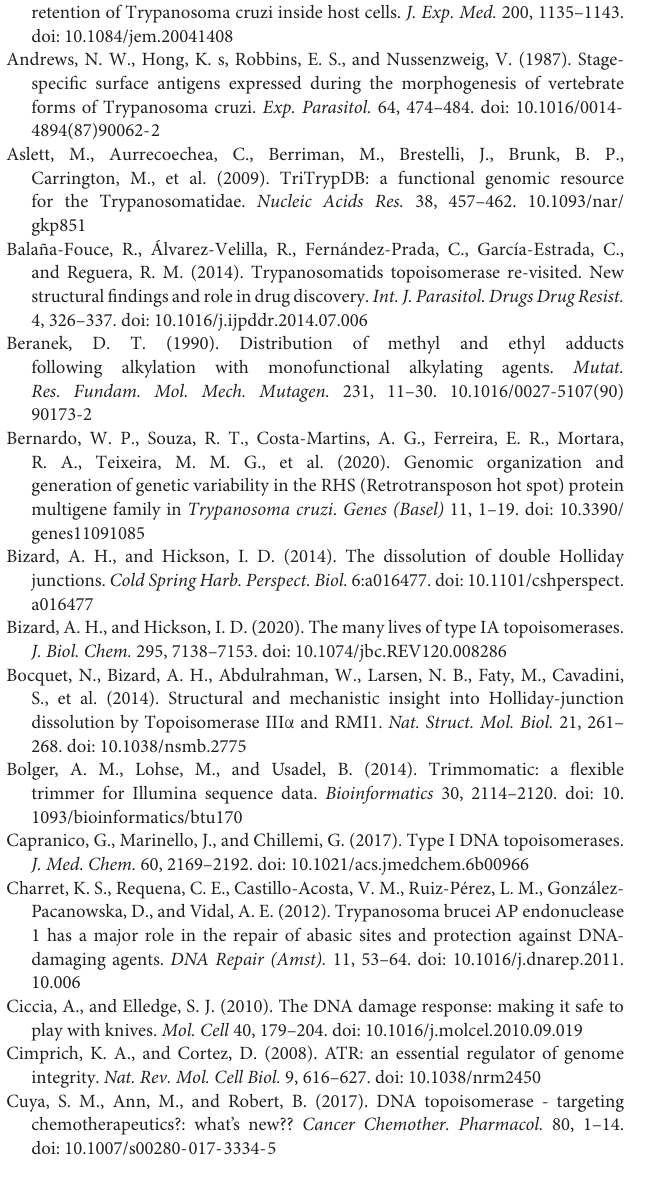
For each multigene family, two heatmaps were generated, one containing the read depth normalized by genome coverage (Raw-Counts), and one with the values normalized by Z-score by column. There was a significant reduction in counts on DGF-1 and RHS gene families, and a mild reduction in Trans-sialidases in MM1 and MM2, when compared with NT1 and NT2. Supplementary Figure 9 | Violin plot representing the gene copy number of DGF-1 genes near replication origins. (A) The Y axis represent the distribution of gene coverages, in log scale. MMS-treated DGF-1 non-origin (MMSNO – red), MMS-treated DGF-1 origin (MMSO – green), Non-Treated non-origin (NTNO – blue), and Non-Treated origin (NTO – purple). (B) Z-statistic and p -values of Dunn’s test. P -values < 0.05 are highlighted in red, and p -values ∼ 0.05 are highlighted in orange. There was no statistically supported difference in coverages of DGF-1 close or distant from replication origins (MMSNO-MMSO and NTNO-NTO).